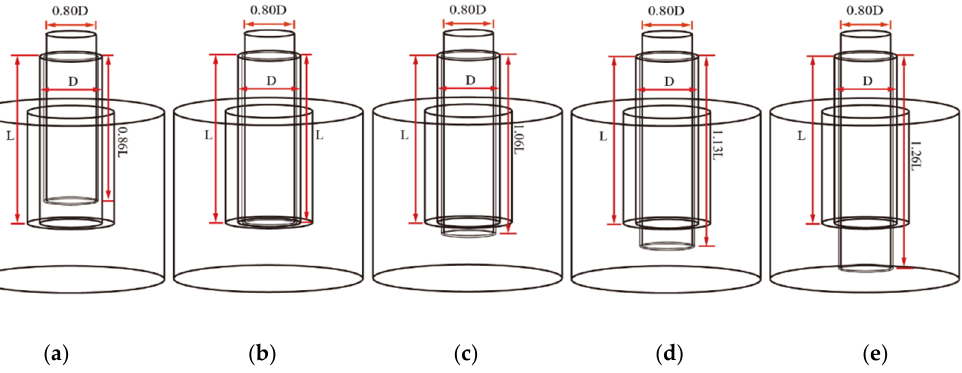
Figure 3. Double vortex-finder hydrocyclone in different length configurations. ( a ) 0.86L ( b ) 1.00L ( c ) 1.06L ( d ) 1.13L ( e ) 1.26L.